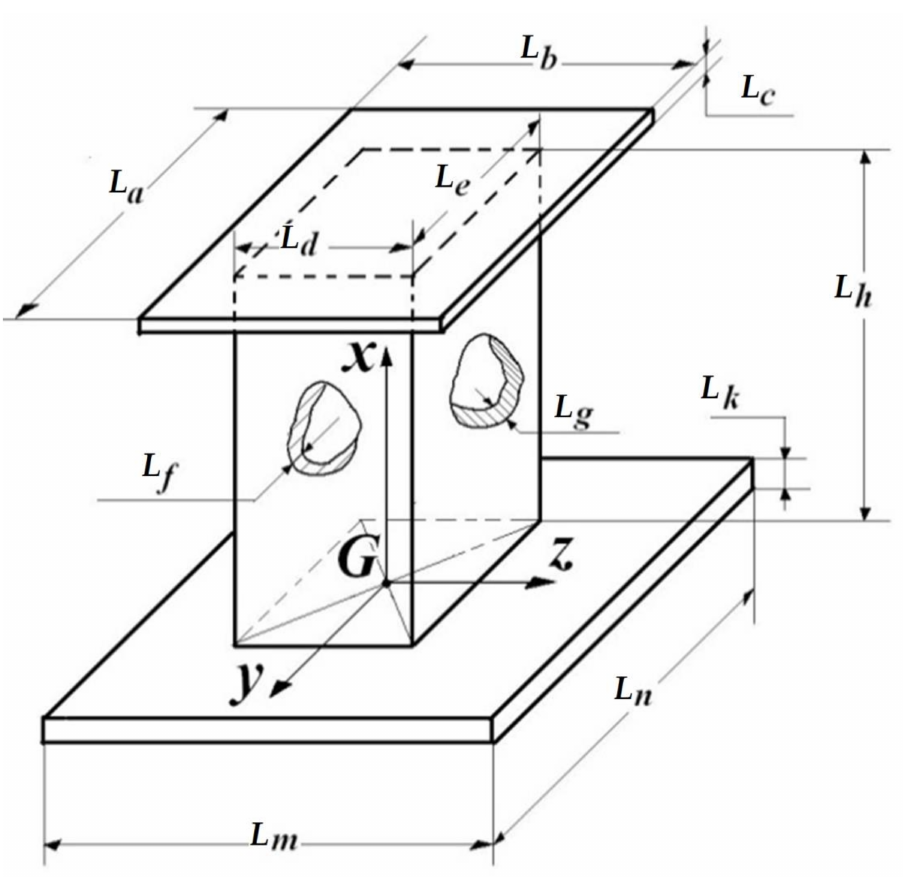
Figure 2. Dimensions of the column